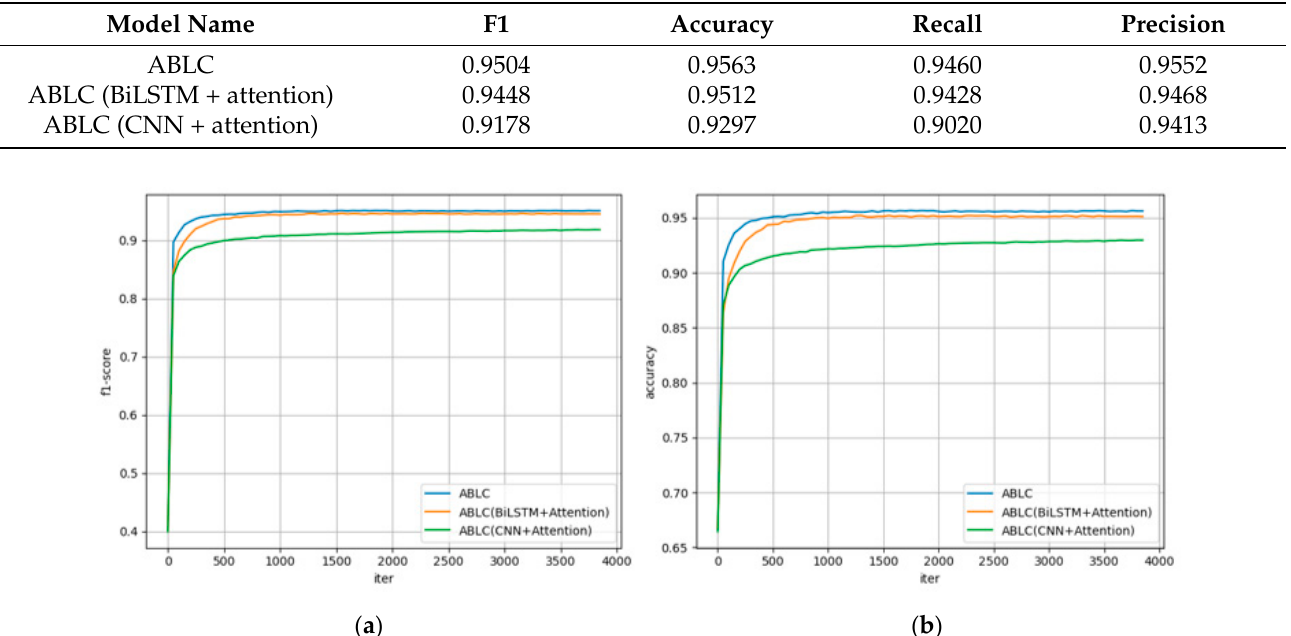
Figure 7. ( a ) F1 score of different models on ablation analysis. ( b ) Accuracy of different models on ablation analysis.